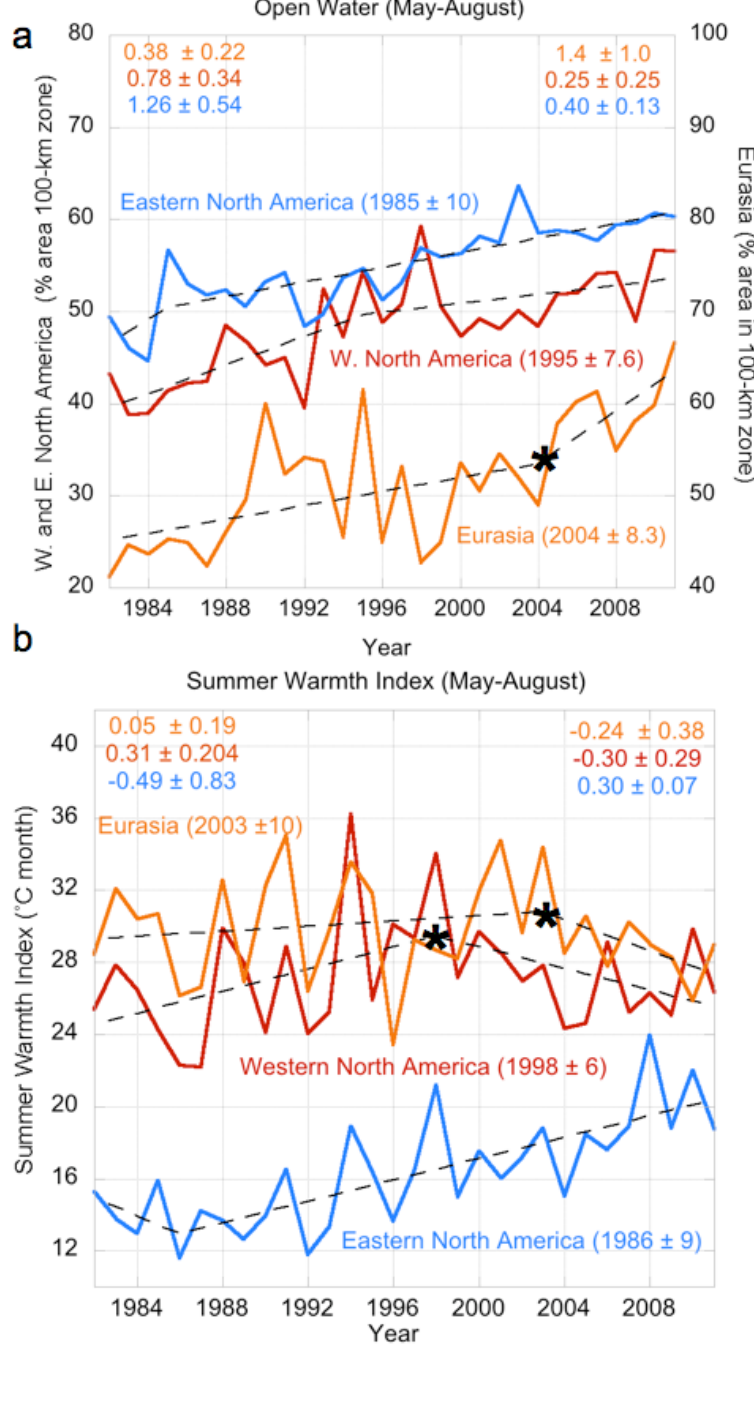
Figure 5. ( a ) Open water (average weekly percent) and ( b ) summer warmth index (°C month) time series for Eurasia (Orange), Western North America (red) and Eastern North America (blue). Trend lines with break points and their associated error are identified for each time series along with the slopes before (top left corner) and after the break points (bottom left corner). Noteworthy break points are identified by a bold star based on the methodology of Mudelsee